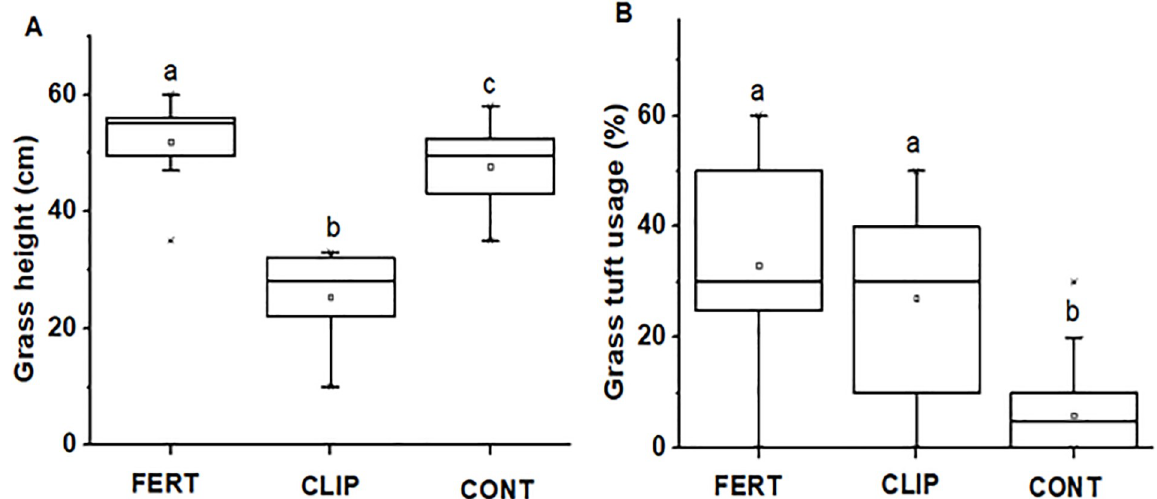
Fig 4. Average (A) grass height and (B) tuft usage between fertilized (FERT), clipped (CLIP) and control plots (CONT). Boxplots show the mean (a square within boxes) and ranges from 25% and 75% quartile, and the tips of the whiskers indicate standard deviation. Boxes with different letter(s) are significantly different by Fisher LSD at P =